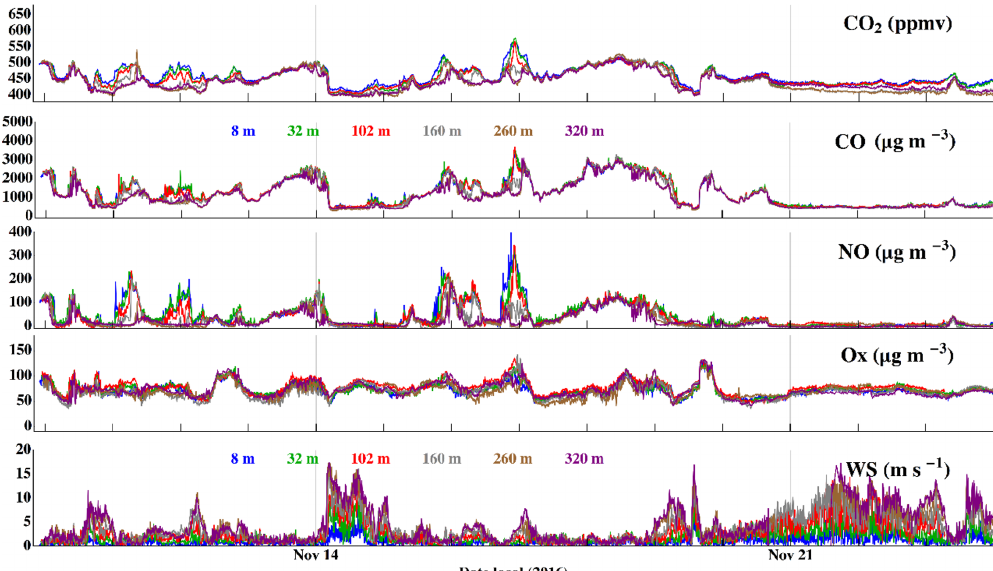
Figure 7. Time series of CO 2 , CO, NO, O x (NO 2 + O 3 ) and wind speed at six heights (colour) measured with SNAQ boxes on the IAP tower during the winter intensive field campaign.